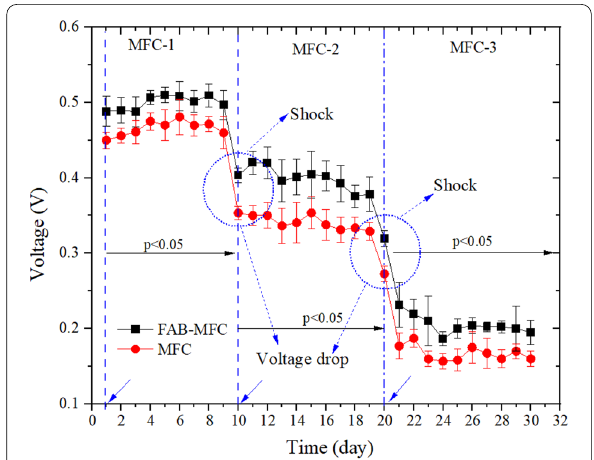
Fig. 8 The voltage generated in the aerobic ‑ MFC integrated domestic wastewater treatment system. Error bars indicate the standard deviation (SD). External load 1000 Ω. The p < 0.05 indicates a significant difference between the FAB–MFC and MFC. A circle with arrows indicates wastewater replacement and system